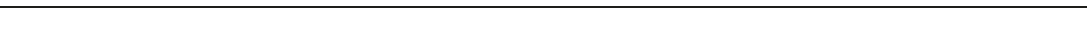
Fig. 7 Autophagy is required for Drp1-mediated longevity. All experiments, except e , were carried out on day 37 in daGS, UAS-Atg1-RNAi > UAS-Drp1 females with or without RU486-mediated transgene induction from day 30 to 37. a qPCR analyses of Atg1 and Drp1 mRNA levels. n = 5 replicates (three fl ies per replicate); * p < 0.05, ** p < 0.01; two-tailed Mann – Whitney test. b – d Immunostaining b of indirect fl ight muscles showing mitochondria ( green channel , anti-ATP5a) and Atg8a foci ( red channel , anti-Atg8a). Quanti fi cation of mitochondrial size c and total number of Atg8a foci d ; n = 6 – 10 fl ies; ** p < 0.01, *** p < 0.001; two-tailed unpaired t -test. e Survival curves with or without RU486-mediated transgene induction from day 30 onwards. The shaded area indicates the duration of Drp1 activation and Atg1 RNAi. p = 0.96, log-rank test; n > 288 fl ies. f In situ respirometry of permeabilized muscles to assess the capacity for oxidative phosphorylation (OXPHOS) and Electron Transport System (ETS) fl ux, and the fl ux control ratio of Complex I by rotenone inhibition. n = 6 replicates (two thoraces per replicate); n.s. indicates not signi fi cant; two-tailed unpaired t -test. g , h Staining of indirect fl ight muscles g showing mitochondria ( green channel , Mitotracker green staining) and levels of superoxide radicals ( red channel , staining with MitoSOX reagent). Quanti fi cation of free superoxide radicals h ; n = 12 replicates; n.s. indicates not signi fi cant; two-tailed unpaired t -test. i , j Immunostaining of indirect fl ight muscles j showing protein polyubiquitinated aggregates ( red channel , muscles stained with phalloidin/F-actin and green channel , antipolyubiquitin). i Quanti fi cation of polyubiquitin aggregates in muscle (as shown j ); n = 16 fl ies; ** p < 0.01; two-tailed unpaired t -test. k , l Western blot k detection